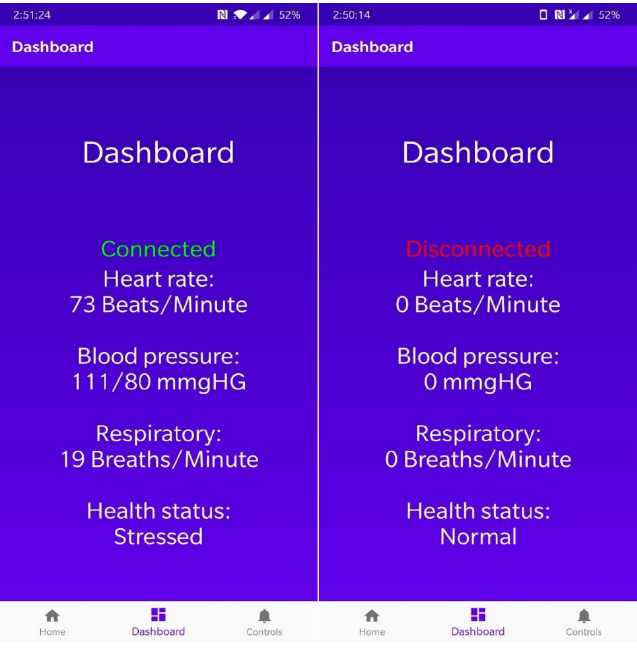
Figure 4. Dashboard screen of Android